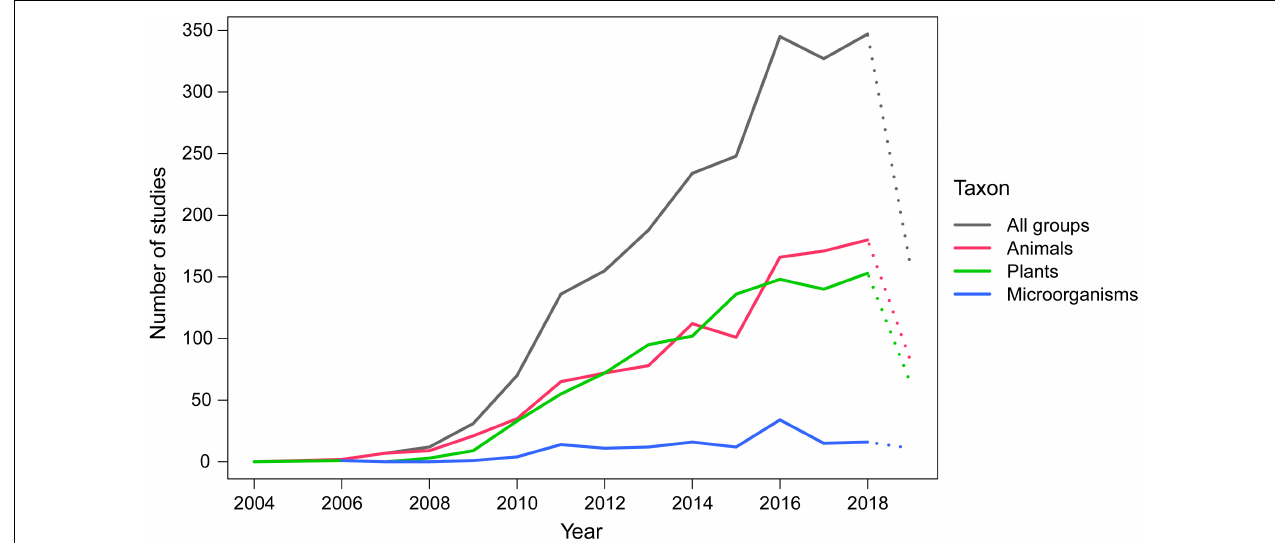
FIGURE 5 | The number of DNA barcoding studies by Chinese scientists published over different years on different taxonomic groups. The X axis represents the year of publication, and the Y axis represents the number of studies. A complete dataset for 2019 is not yet available and is shown as a dotted line. The count of articles on different taxonomic groups is not completely mutually exclusive – some articles involve two or more taxonomic groups, and these articles were used to estimate the statistics for each taxonomic group respectively. Therefore, the total number of articles is not a simple sum of the number of articles of the three